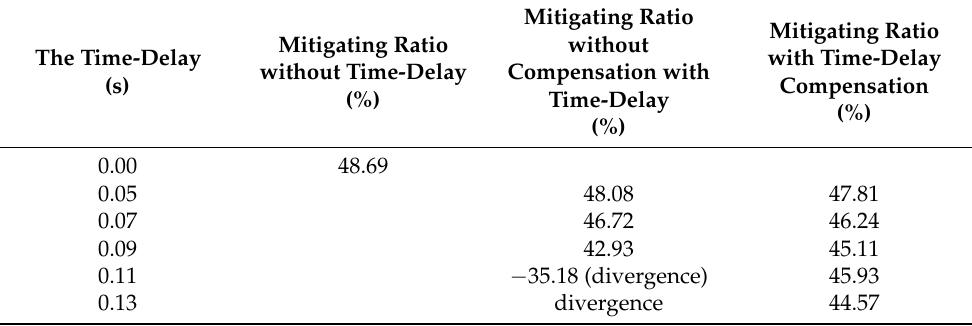
Table 7. Experimental response reductions at mid-span under random